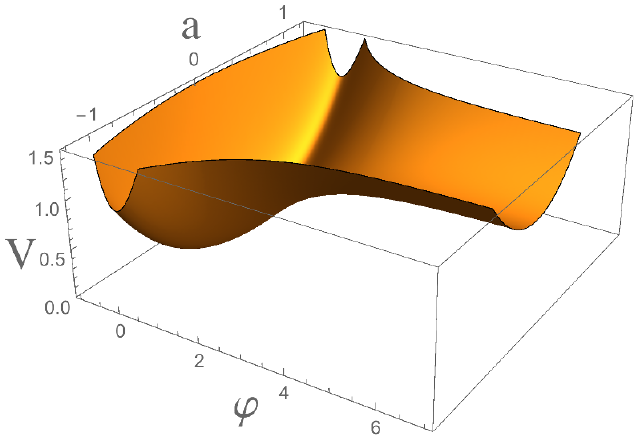
Figure 3 . Basic E-model with (cid:11) = 1 =